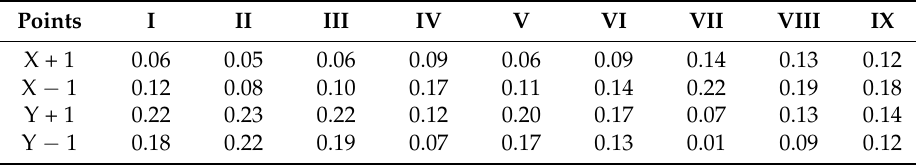
Table 2. Diffraction efficiency testing result of the grating fabricated with polarization.